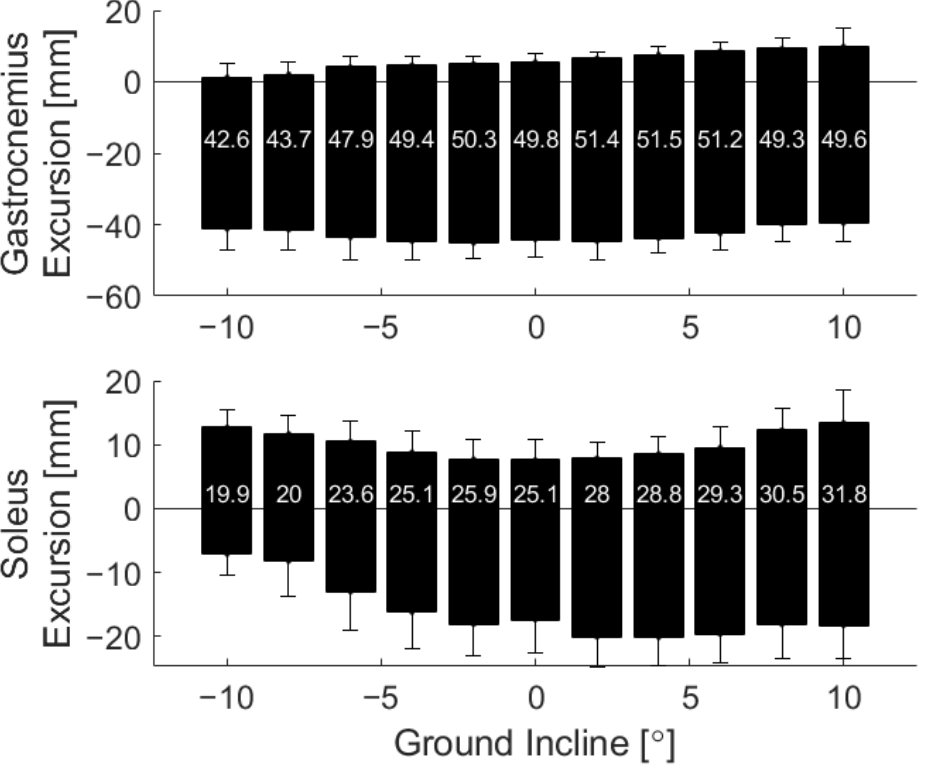
Figure A2. Mean excursion of the soleus and gastrocnemius muscle–tendon length, relative to the length in an upright posture, at each of the slope bins. Error bars represent one standard deviation.